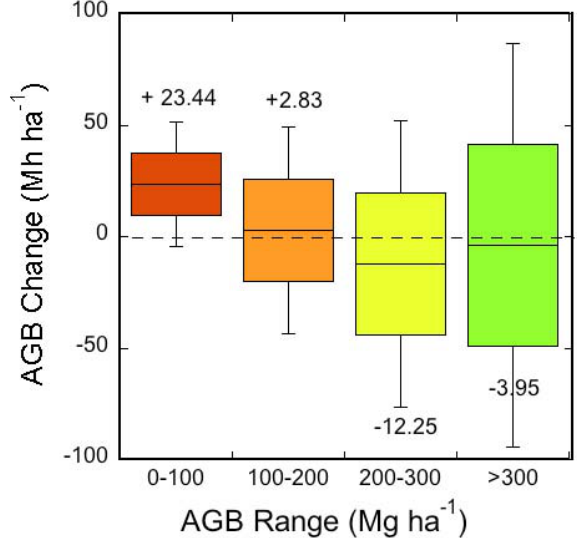
Fig. 9. DBH classes and AGB change (20m spatial scale). AGB is increasing in small DBH classes while trees having DBH higher than 40m are losing biomass.